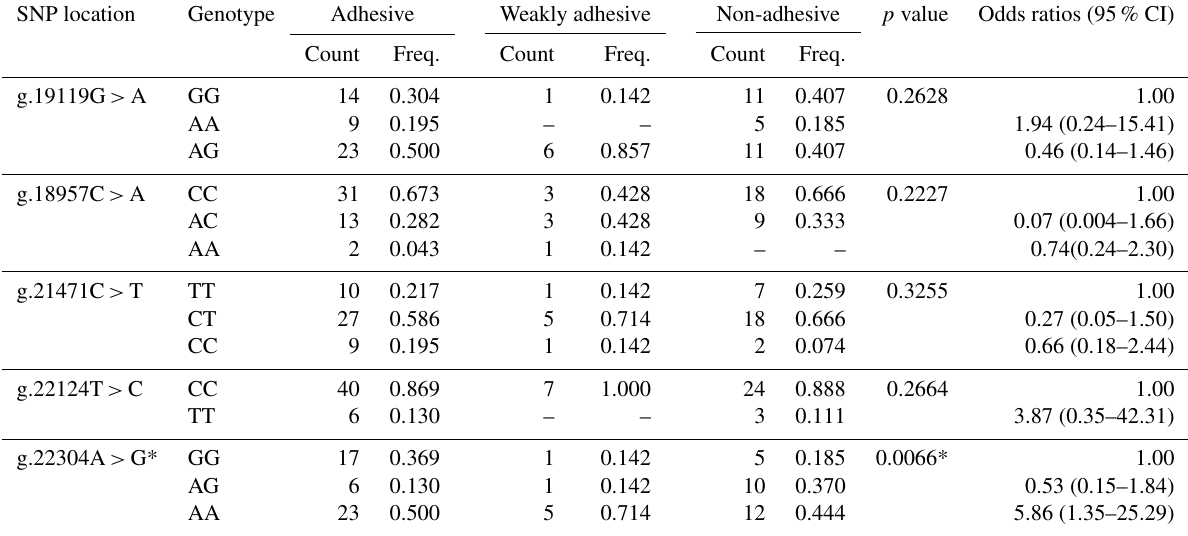
Table 2. Genotype frequency distribution of porcine MUC13 gene polymorphism. SNP location